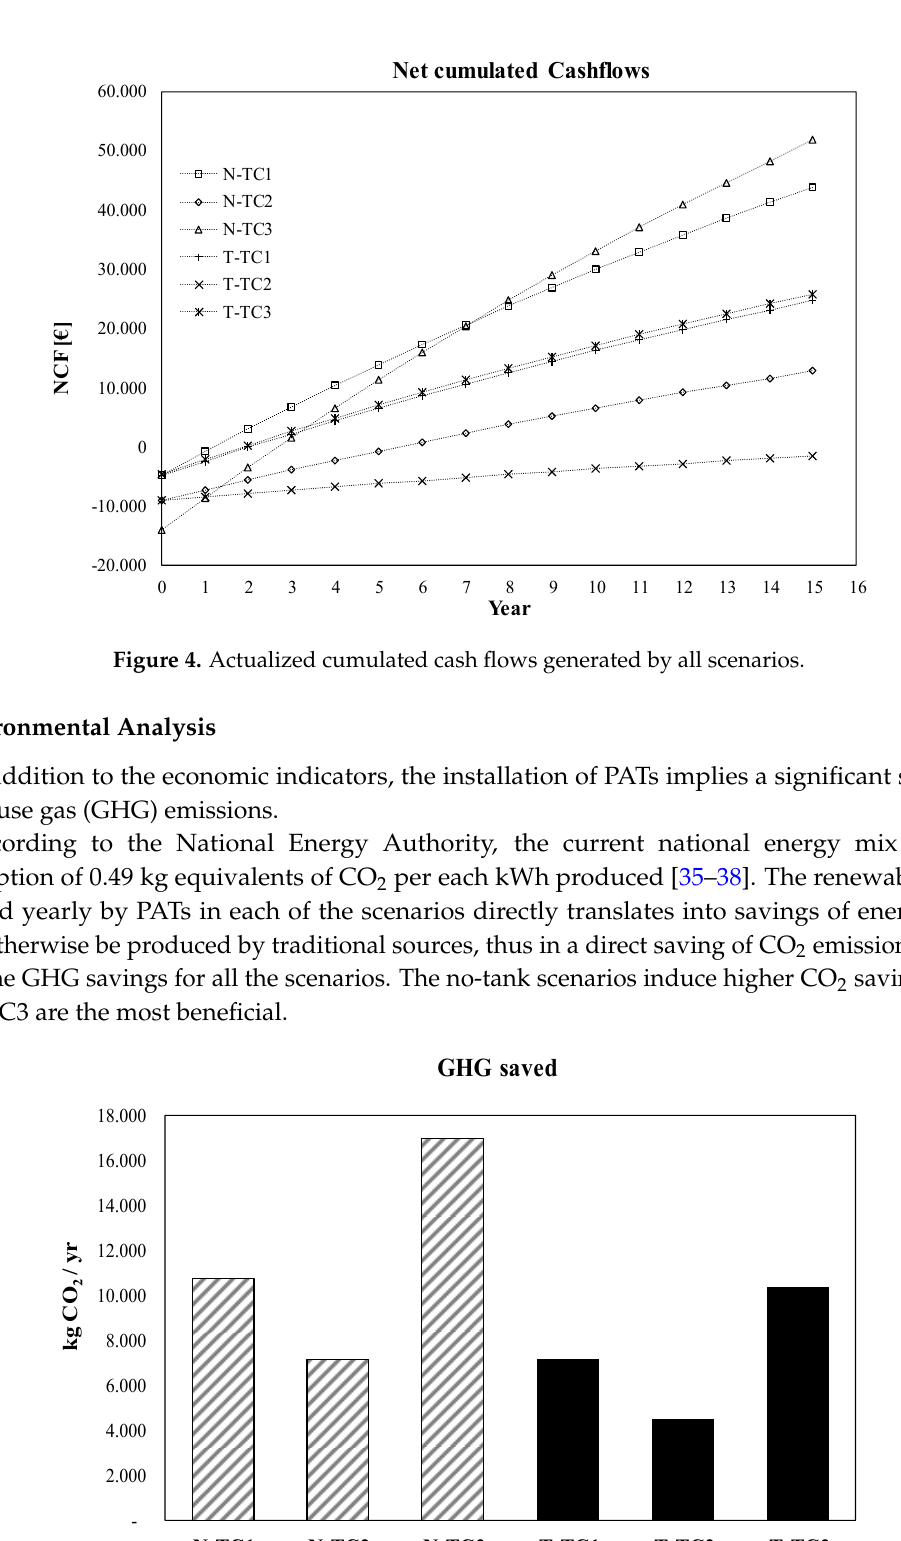
Figure 3. Net actualized cash flows generated in all scenarios.